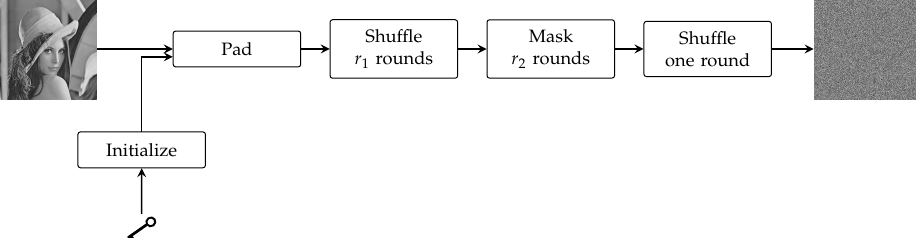
Figure 1. Overview of the proposed image encryption